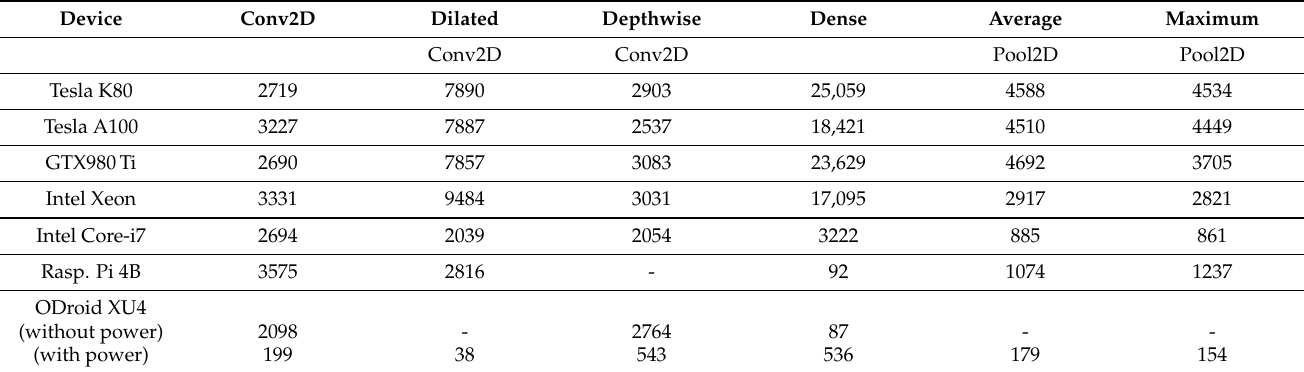
Table 3. Overview of the collected datasets. The XU4 has been measured with and without the recording of the power consumption during the